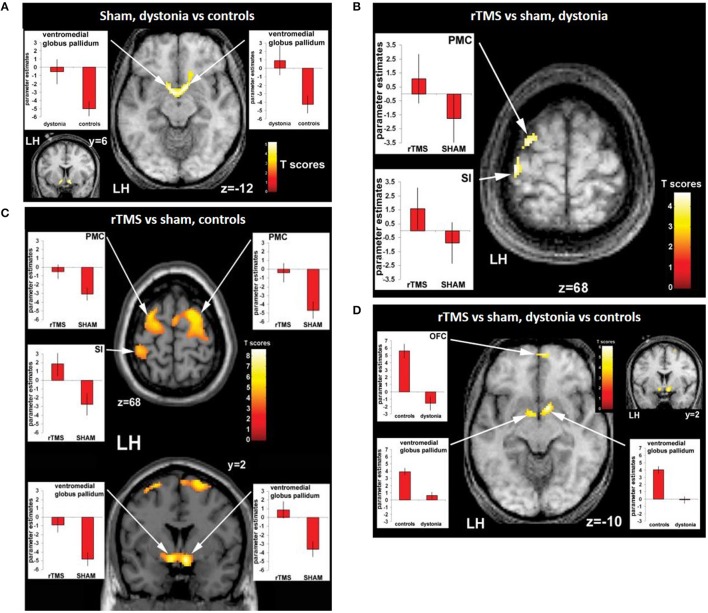
Evidence of functional connectivity abnormalities in patients with dystonia and changes following rTMS. (A) Connectivity maps of patients vs. controls during the sham condition showing bilaterally greater activity in the ventromedial pallidum of patients compared to healthy controls. Effects of rTMS (real versus sham condition) on neuronal activity during sensory discrimination task in dystonia patients (B) and controls (C). Both patients with dystonia (B) and healthy controls (C) show relatively greater activity ipsilaterally in the left premotor cortex (PMC) and the left sensorimotor cortex (S1) following after real-rTMS compared to sham stimulation. In addition, there is activation of the ventromedial pallidum bilaterally in healthy controls, but not in patients with dystonia. (D) Interaction (group × condition) during rTMS in patients with dystonia compared to controls. Compared to controls, dystonia patients show reduced activity in the left oribtofrontal cortext (OFC) and the ventromedial pallidum bilaterally after real-rTMS compared to sham stimulation (D). Image from Schneider et al. (2010). Permission to reuse Figures 3 and 4 from the article was granted by John Wiley and Sons and Copyright Clearance Center through their RightsLink® service on 13th of February 2018.